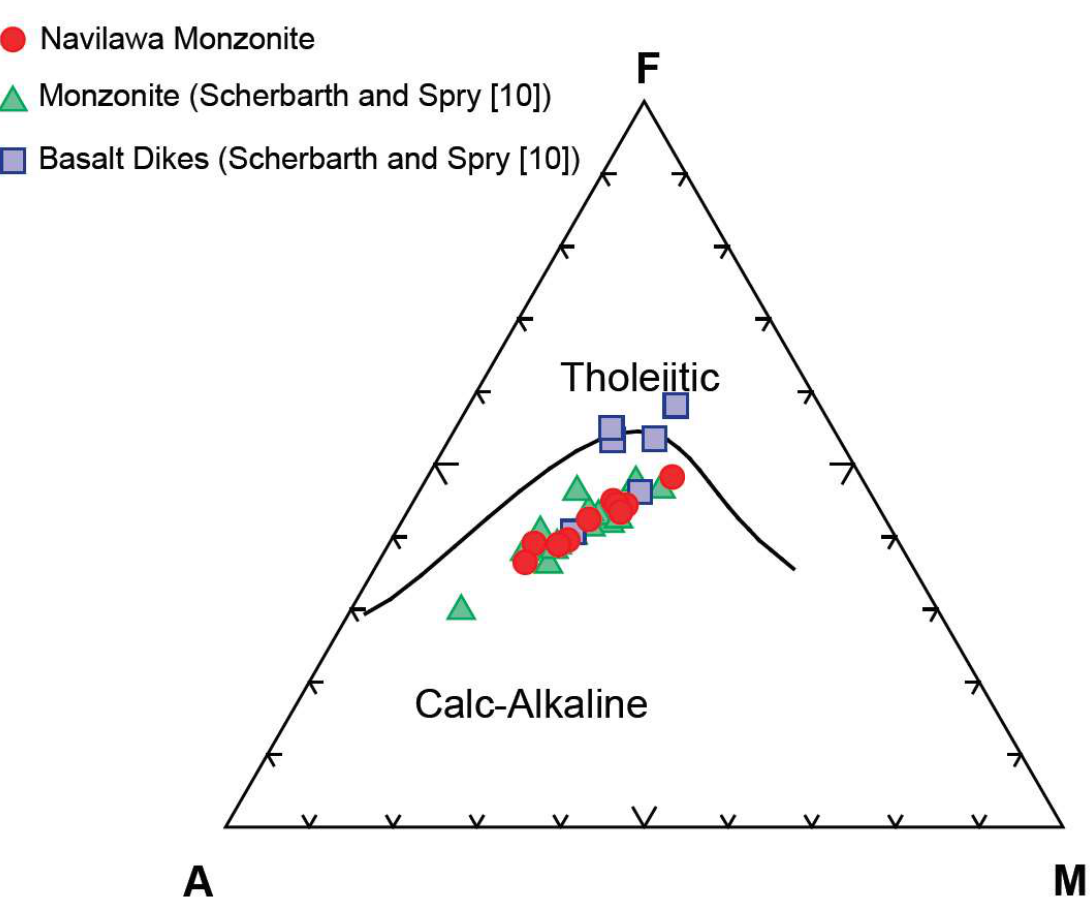
Figure 5. AFM diagram of the Navilawa Monzonite from this study and Scherbarth and Spry [10] along with basaltic–andesite dikes from [10]. A = Na 2 O + K 2 O, F = Fe 2 O 3 *0.8998, M =